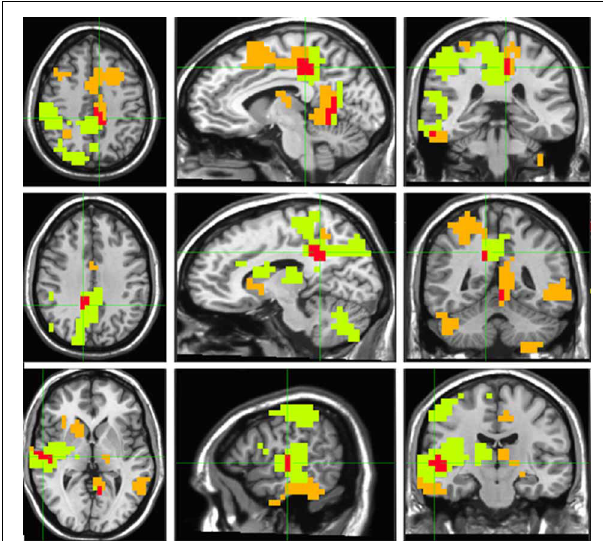
FIGURE 4 | Beamforming source estimates for the overlap between Timelessness vs. Now and Spacelessness vs. Here contrasts in the theta (4–8Hz) frequency. Axial, sagittal and coronal views (left to right) of group ( n = 11) SAM pseudo- F source estimates overlayed on the Colin template. Note that in all images right and left sides are crossed. Green, orange, and red indicate Timelessness, Spacelessness and overlap between conditions, respectively. Top : left cingulate/precuneus and culmen (clusters 2 and 4, respectively, Table 3 ); Center : right cingulate/precuneus (cluster 1, Table 3 ); Bottom : right superior temporal gyrus (cluster 3, Table 3